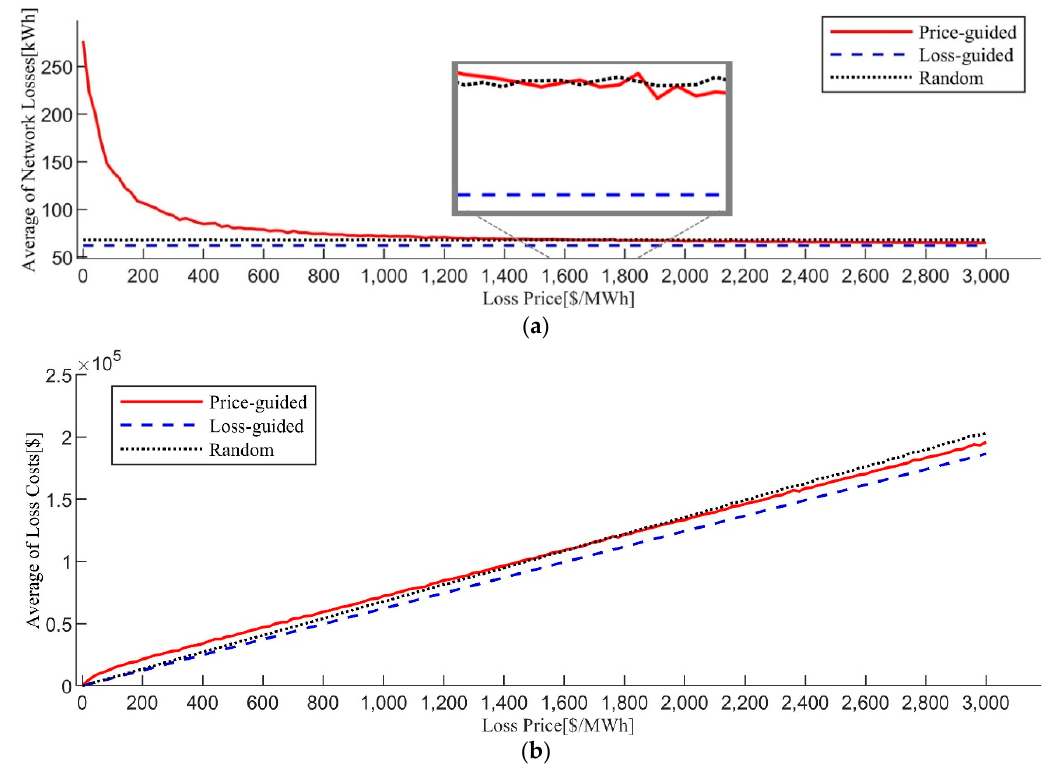
Figure 9. Average of ( a ) Network Losses and ( b ) Loss Costs with Increase in Loss Price.